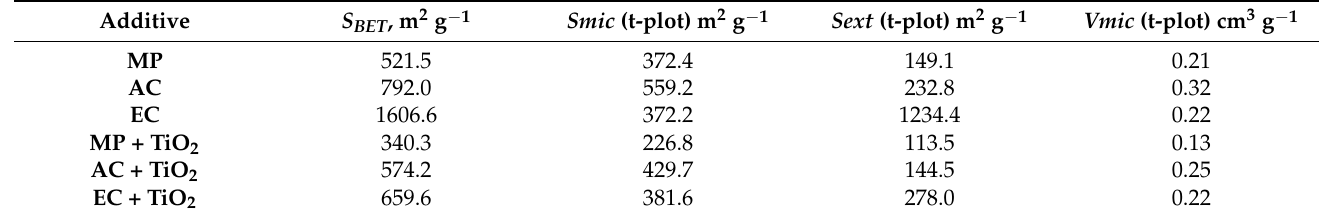
Figure 2. Nitrogen adsorption/desorption isotherms at 77 K of (from top to bottom) electrochemical carbon (EC, red line), commercial activated carbon (AC, black line) and mesoporous carbon (MP, blue line). The adsorption branch of the isotherm is marked with open circles, while the desorption branch is marked with crosses. Adsorption isotherms of carbon composites with TiO 2 are depicted with full circles and lines of the same color as isotherms of corresponding pure carbon. Table 1. Structural parameters of carbonaceous